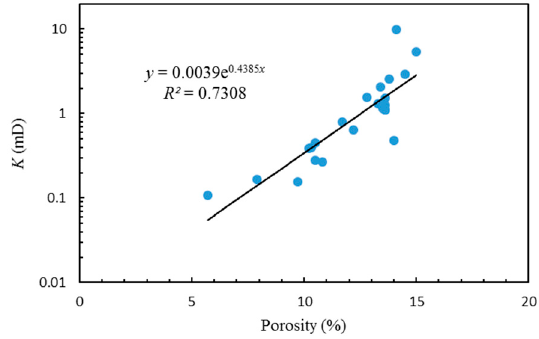
Figure 2. The relationship between the porosity and permeability.